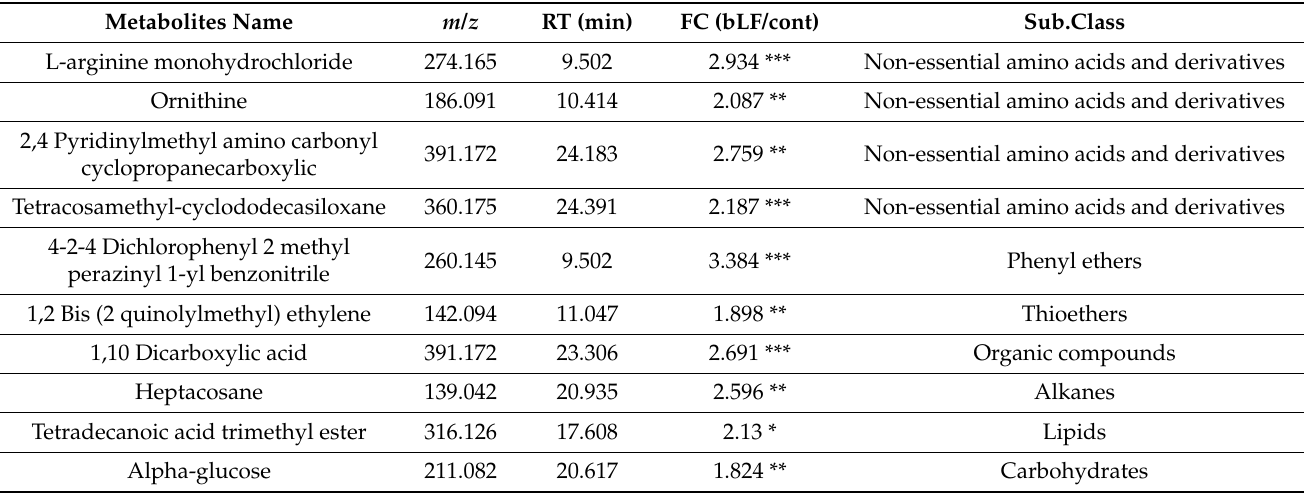
Figure 6. GC-MS and LC-MS multivariate analysis of metabolite profiles in plasma of pups recovered from mothers receiving bLF (LF) or mothers receiving no supplement (Cont). ( A ) GC-MS orthogonal projections of latent structures discriminant analysis (OPLS-DA) score plots of plasma metabolites in the control (green) and lactoferrin (blue) pups. LF vs. Cont ( p < 0.01). ( B ) Loadings plots highlighting discriminant metabolites. ( C ) LC-MS orthogonal projections of latent structures discriminant analysis (OPLS-DA) score plots of plasma metabolites in the control (green) and lactoferrin (blue) pups. LF vs. Cont ( p < 0.01). ( D ) Loadings plots highlighting discriminant metabolites. Table 7. GC-MS analysis of metabolites in plasma of pups recovered from mothers receiving the control diet or the bLF-supplemented diet. The parameters were determined at postnatal day 17. The metabolites presented in the table are those for which plasma concentrations are significantly different when comparing the control and the bLF-supplemented